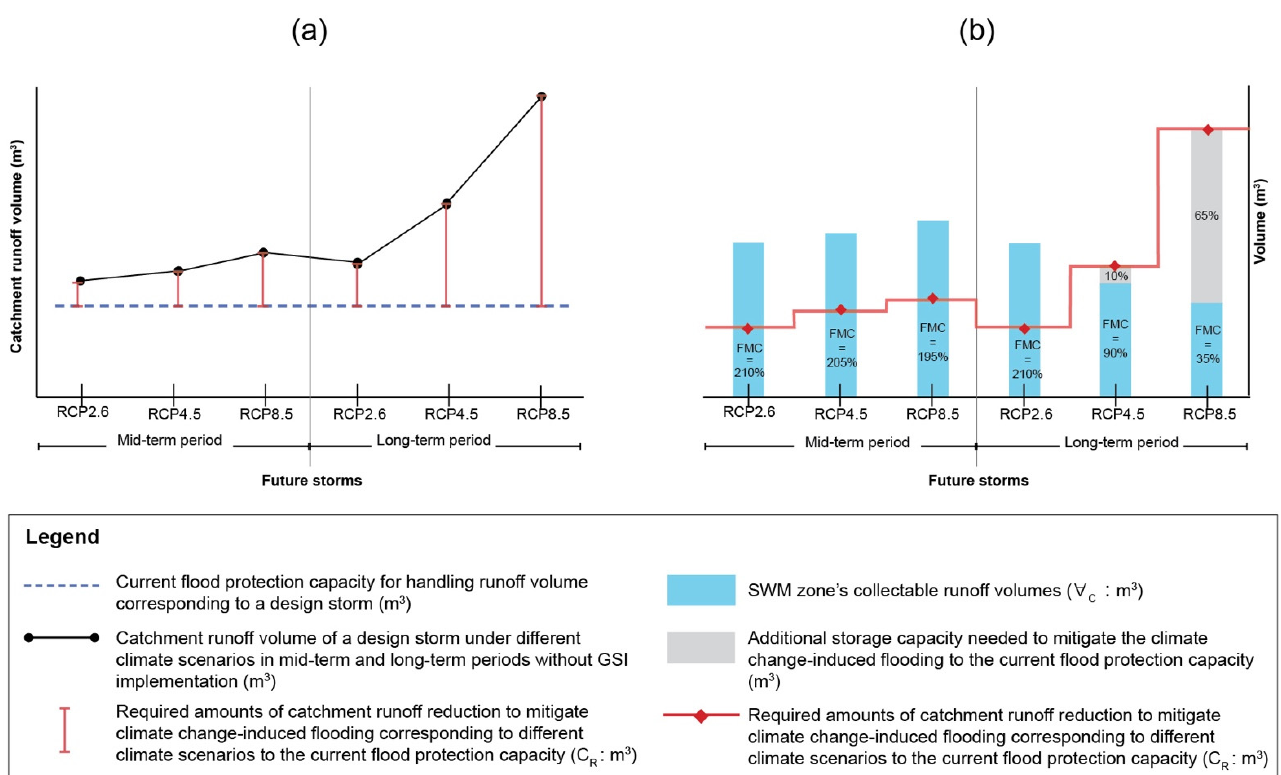
Figure 6. Zone 1A’s collectable runoff volumes under different climate scenarios are illustrated in blue in ( b ) compared with the required amounts of runoff reductions to avoid flooding (solid red line). The amount needed to mitigate flooding to below the current flood protection capacity is calculated by determining the difference in volume between the dotted blue line indicating the current flood protection capacity and the solid black line presenting the increased catchment runoff volumes with climate change ( a ).